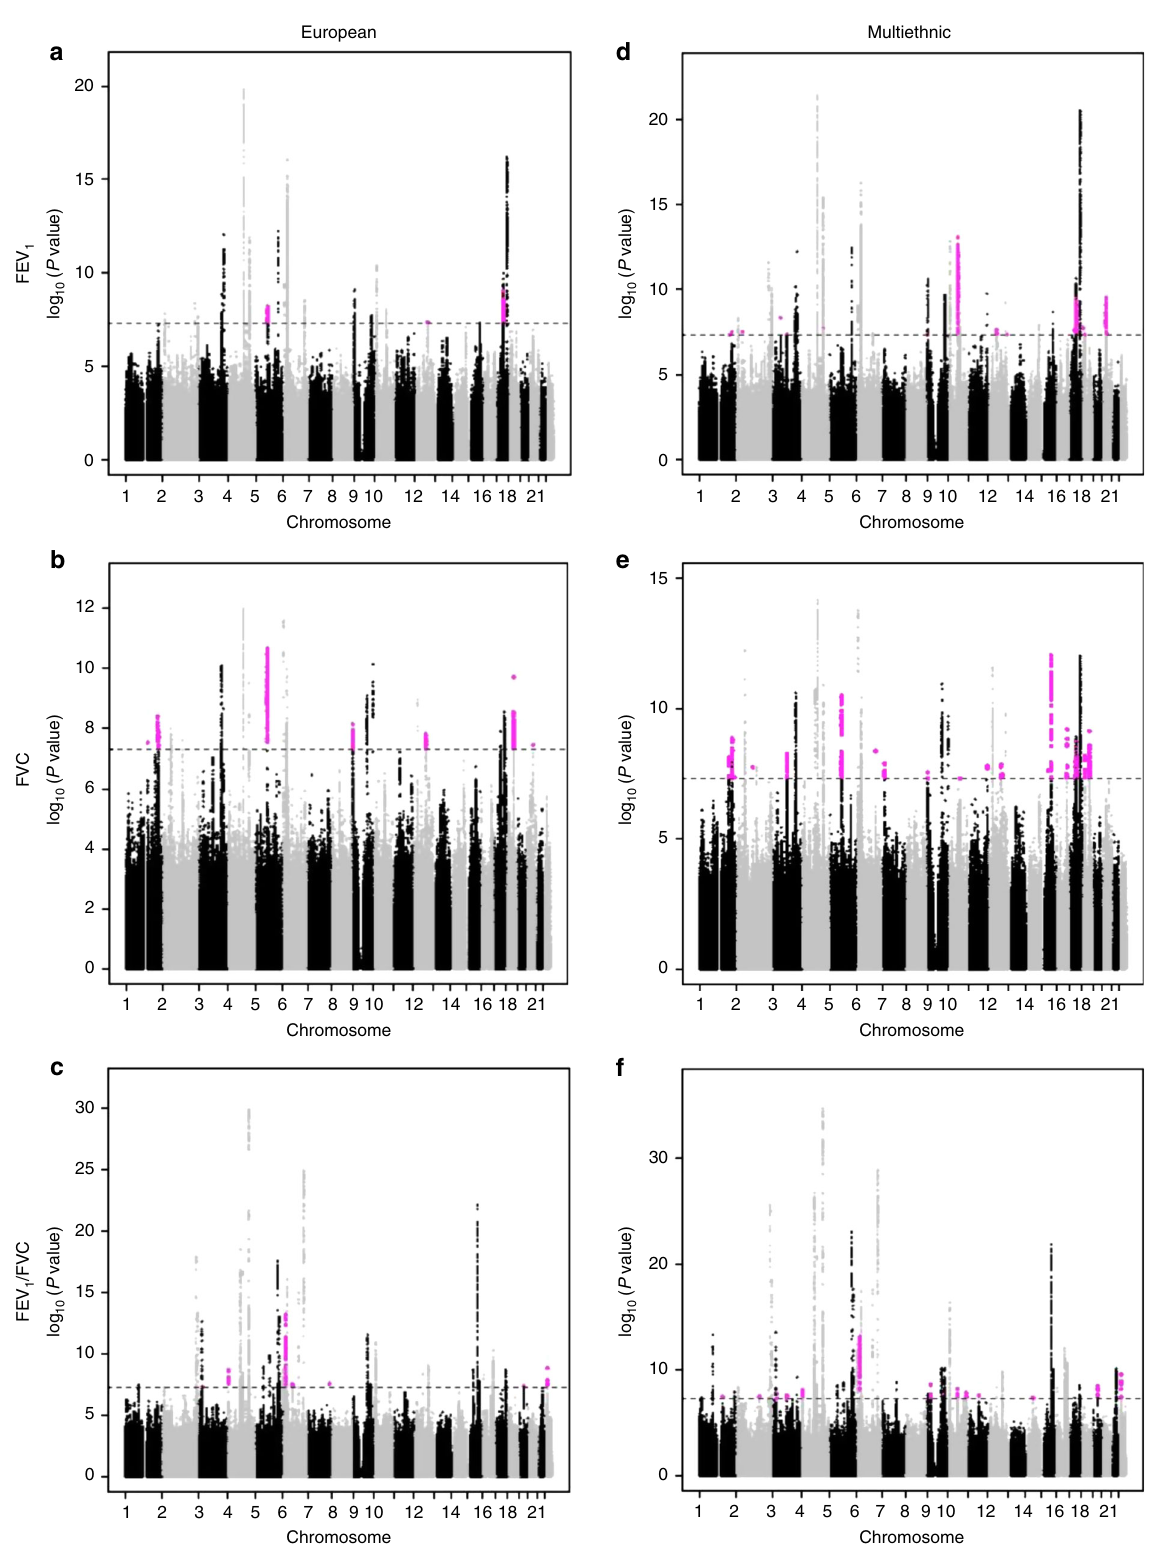
Fig. 1 Manhattan plots of genome-wide association results for pulmonary function in the following CHARGE meta-analyses: a FEV 1 European ancestry; b FVC European ancestry; c FEV 1 /FVC European ancestry; d FEV multiethnic; e FVC multiethnic; f FEV 1 /FVC multiethnic. Novel loci indicated by magenta. Signi fi cance level (5x10 ‒ 8 ) indicated by dashed